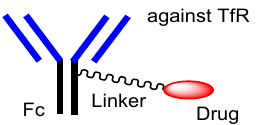
Figure 7. The structures of anti-TfR (transferrin receptor) antibody-drug conjugate (ADC), containing cancer drugs via pH-sensitive cleavable linkers.